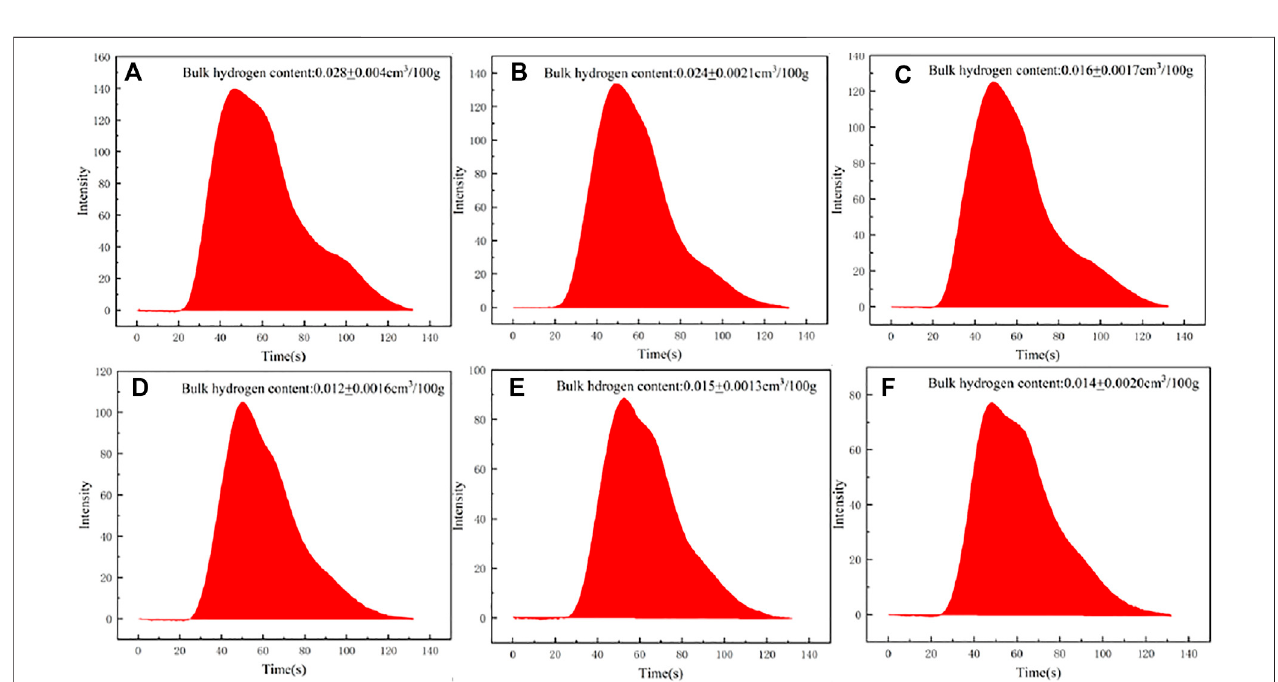
FIGURE3| Hydrogen contentdetection curves of (A) thecenter ofDSU-treated ingot, (B) the half-radius ofDSU-treated ingot, (C) theedgeofDSU-treatedingot, (D) the center of TSU-treated ingot, (E) the half-radius of TSU-treated ingot, and (F) the edge of TSU-treated ingot.